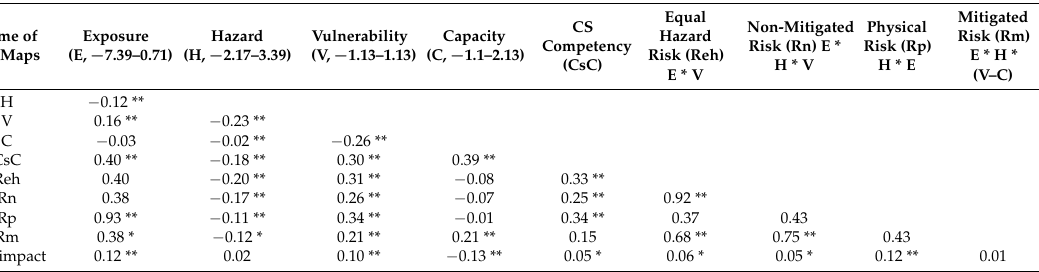
Table 2. Correlation matrix among vulnerability, exposure, capacity, risk and Sidr impact maps. Pearson correlation has been calculated as pixel level. Numbers in parentheses refers to the ranges of values of the components.